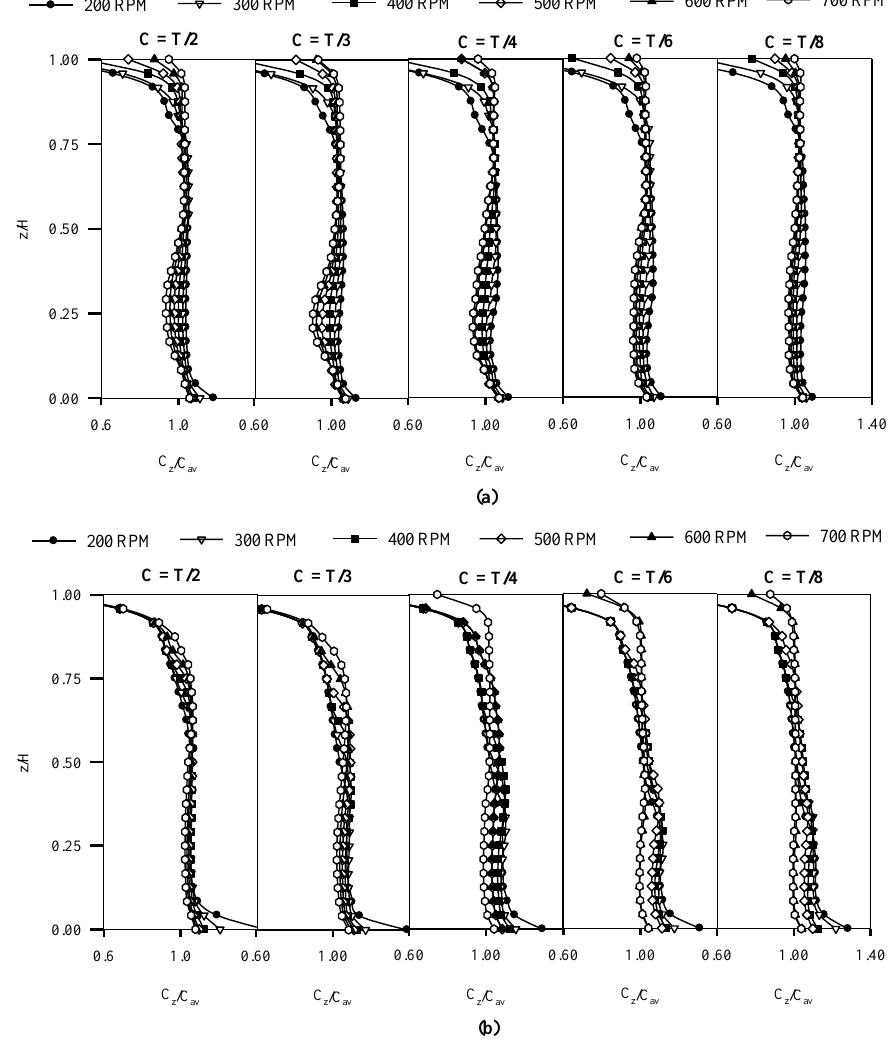
Figure 5. Axial concentration profiles at different stirrer speeds and off-bottom clearance for impeller to tank diameter ratio of ( a ) 0.5 and ( b )